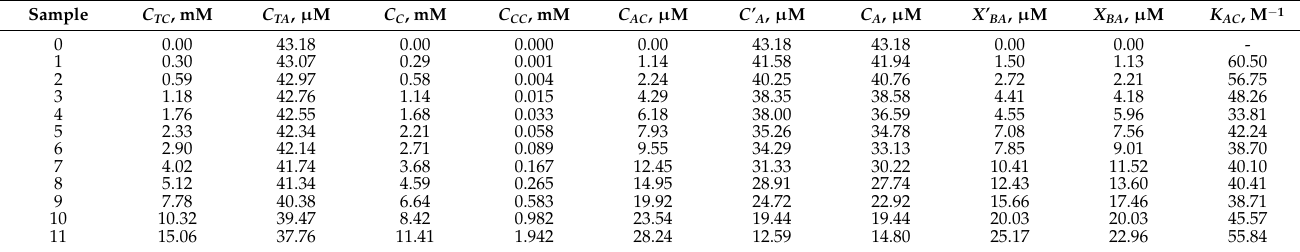
C TC , total caffeine concentration; C TA , total tetracycline concentration; C C , caffeine monomer concentration; C CC , caffeine homoaggre- gate neighborhood concentration; C AC , tetracycline-caffeine heteroaggregates neighborhood concentration; C’ A , tetracycline monomer concentration (determined spectrophotometrically); C A , tetracycline monomer concentration; X’ BA , tetracycline in heteroaggregates with caffeine concentration (determined spectrophotometrically); X BA , tetracycline in heteroaggregates with caffeine concentration; K AC , tetracycline-caffeine neighborhood association constant. Mean K AC ± standard error, 45.6 M − 1 ± 2.5 M − 1